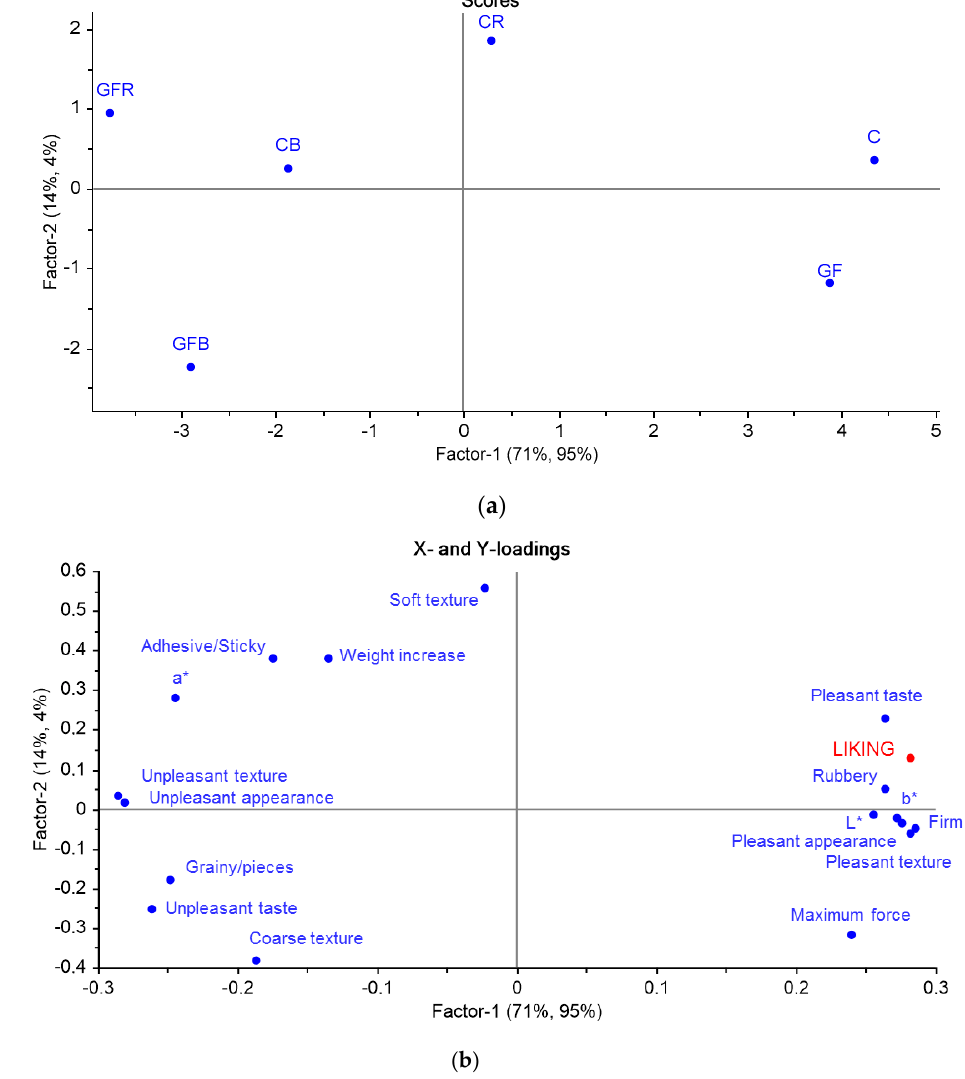
Figure 4. Scores ( a ) and loadings ( b ) plots obtained by the Partial Least Square Regression (PLSR) model of the six gnocchi samples based on CATA questions, technological variables, and liking.